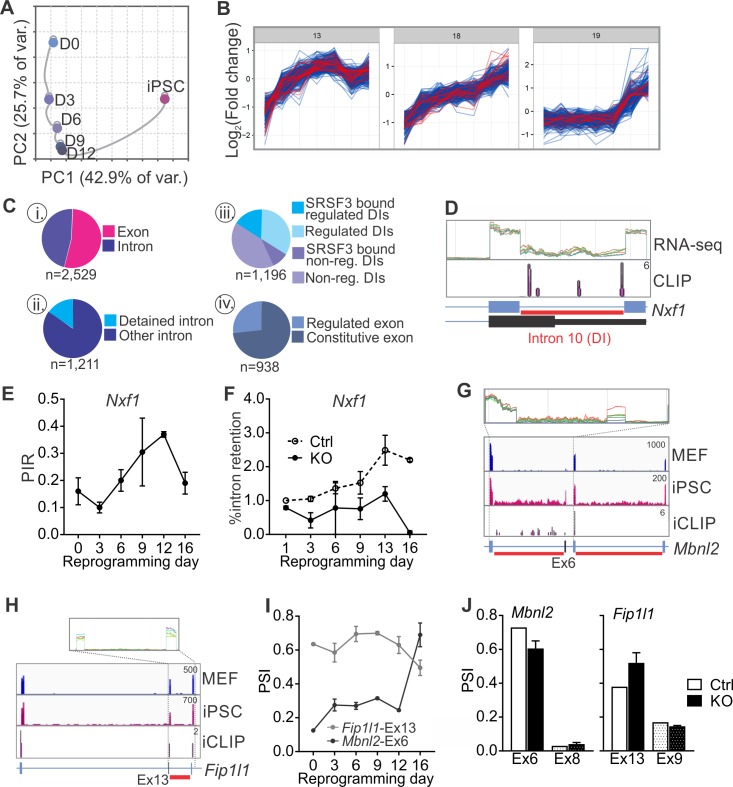
SRSF3 regulates the alternative splicing of Nxf1 and other RNA regulators during reprogramming.(A) Principal component analysis of regulated RNA features based on JunctionSeq during reprogramming, depicting similarity of exon/junction usage between reprogramming intermediates. (B) Unsupervised k-means clustering of regulated RNA features during the reprogramming time course. SRSF3 associated regulated RNA features, SARFs, are highlighted in red. SRSF3 binding sites within the feature or [−200, +200 nt] window up- or down-stream of the junction were included in the analysis. Top three clusters with most SRSF3-binding sites are shown. (C) (i) Distribution of SRSF3-binding sites within regulated exons and introns. Regulated RNA features were classified as exons and introns using RefSeq annotation. (ii) Proportion of intronic SARFs that were classified as detained introns (Boutz et al., 2015). (iii) Distribution of SRSF3 binding sites within regulated and non-regulated (non-reg.) DIs. (iv) Proportion of SARFs that are DIs and flank an exon regulated during reprogramming. (D) Expression of Nxf1 Ex10-Int10-Ex11 during reprogramming and SRSF3 iCLIP binding profile within the transcript region. The red bars below the gene diagram denote DIs based on (Boutz et al., 2015). Colour coding from blue (MEF) to red (iPSC). The read counts were normalised within the genes. (E) Dynamic changes in Nxf1-Int10 retention during reprogramming as measured by RNA-seq (data as mean ± SEM, n = 2). PIR, percent intron retained. (F) RT-qPCR quantification of Nxf1-Int10 retention during reprogramming in control (Ctrl) and SRSF3-depleted (KO) cells. The data is represented as percent of transcripts with the retained intron (data as mean ± SEM, n = 2). (G) Expression of Mbnl2 exons 5–8 and SRSF3 iCLIP binding profile within the transcript region. The red bars below the gene diagram denote DIs based on (Boutz et al., 2015). The alternative exon six is highlighted in black in the gene diagram. Colour coding from blue (MEF) to red (iPSC). The read counts were normalised within the genes. (H) Expression of Fip1l1 exons 12–14 and SRSF3 iCLIP binding profile within the transcript region. The red bars below the gene diagram denote DIs based on (Boutz et al., 2015). The alternative exon 13 is highlighted in black in the gene diagram. (I) Dynamic changes in Mbnl2-Ex6 and Fip1l-Ex13 inclusion during reprogramming as measured by RNA-seq (data as ± SEM, n = 2). PSI, precent spliced in. (J) Quantification of Mbnl2-Ex6 and Fip1l-Ex13 inclusion in control (Ctrl) and Srsf3-KO (KO) iPSCs by RNA-seq (data as mean ± SEM, n = 2). Unaffected alternative exons that were not associated with SRSF3 binding sites (Mbnl2- Ex8 and Fip1l1-Ex9) are shown for comparison. PSI, percent spliced in. See also Figure 6—figure supplement 1, Figure 6—source data 1 and 2.10.7554/eLife.37419.021Figure 6—source data 1.Read-wide mapping statistics.10.7554/eLife.37419.022Figure 6—source data 2.Data file containing JunctionSeq output.